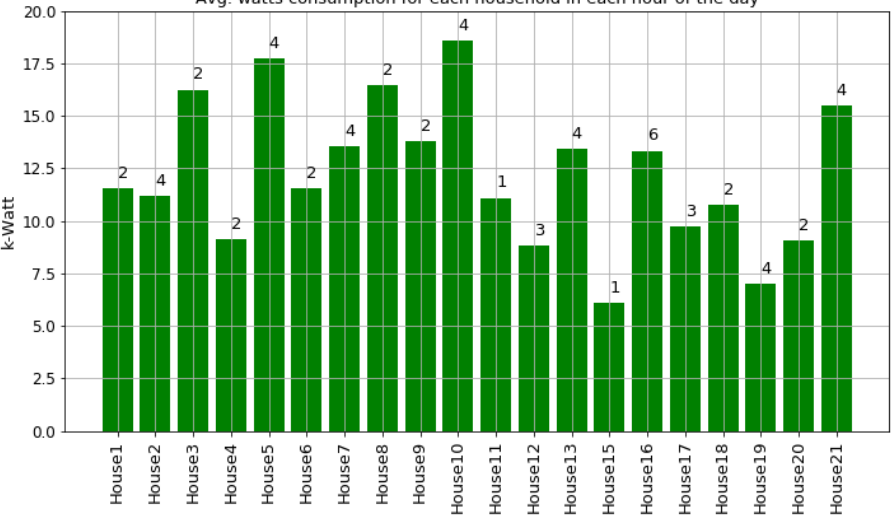
Figure 7. The average household k-Watt consumption for each household in each hour of the day. The numbers at the top of bars are the household occupancy.